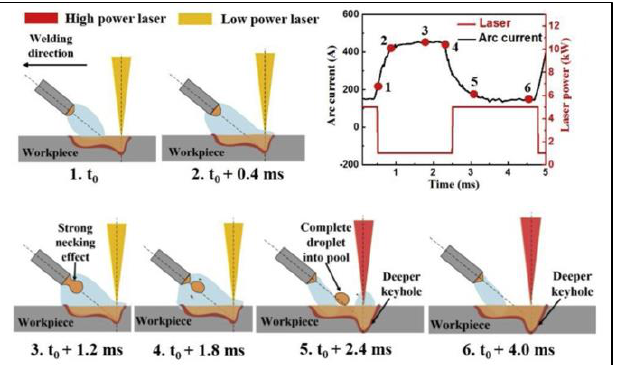
Figure 25. The droplet transfer behavior in anti-phase LAHW [110]. Reprinted with permission from [110] 2020 Elsevier.